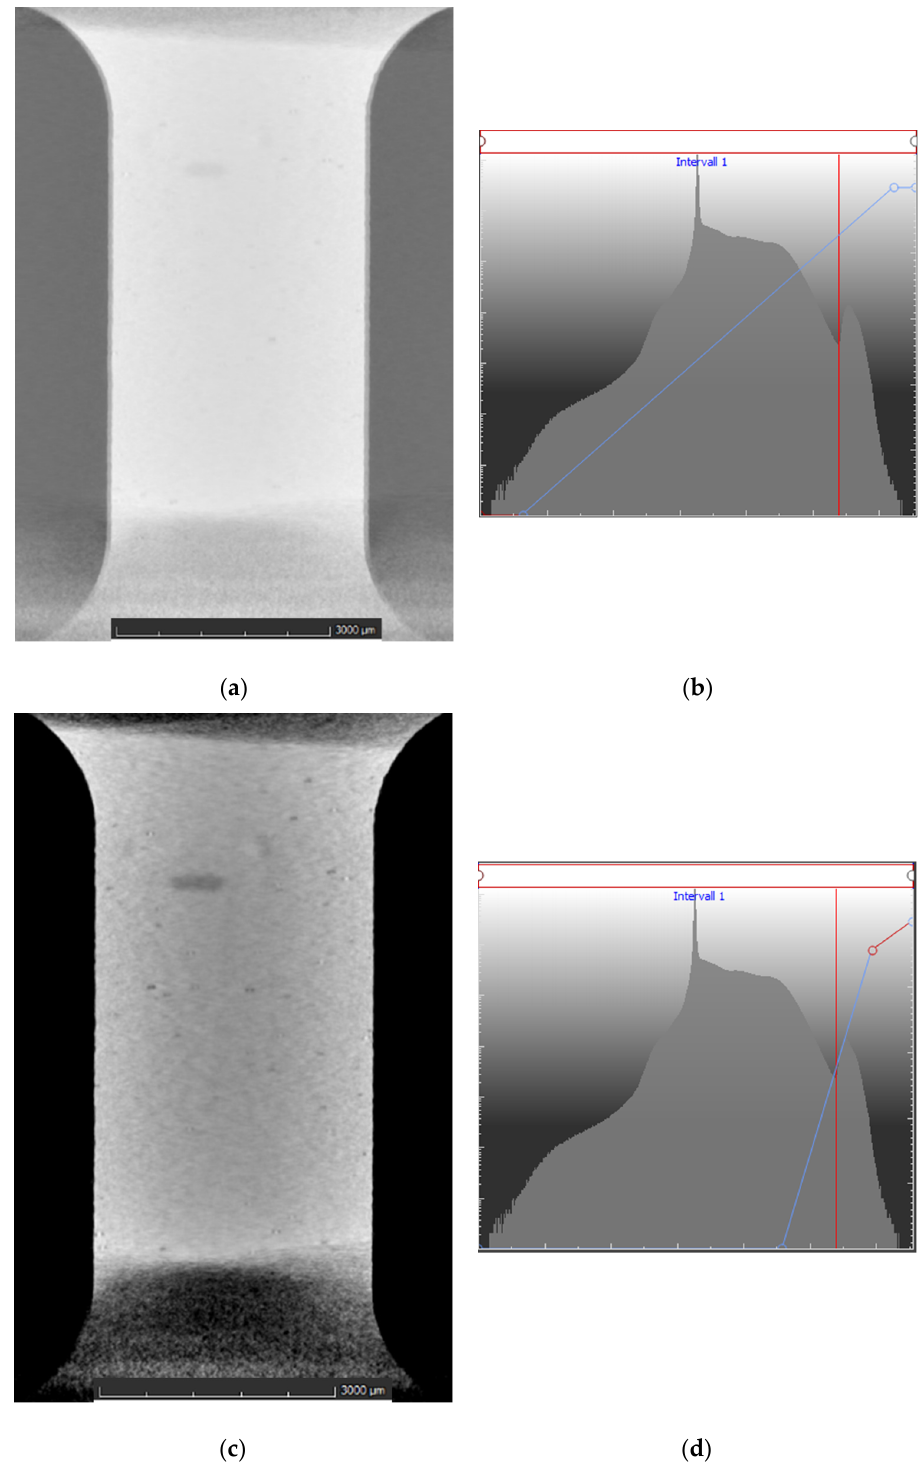
Figure 2. Different greyscale histograms and their respective influence on the scanned part: ( a ) re- constructed volume, as scanned, without any optimisation of brightness and contrast; ( b ) greyscale histogram for ( a ); ( c ) reconstructed volume with optimisation of brightness and contrast; and ( d ) greyscale histogram for ( c ). The histograms in ( b , d ) have the grayscale from 0-32000 (16-bit grayscale figure) as the x-axis, and the logarithmic intensity is given as the y-axis.